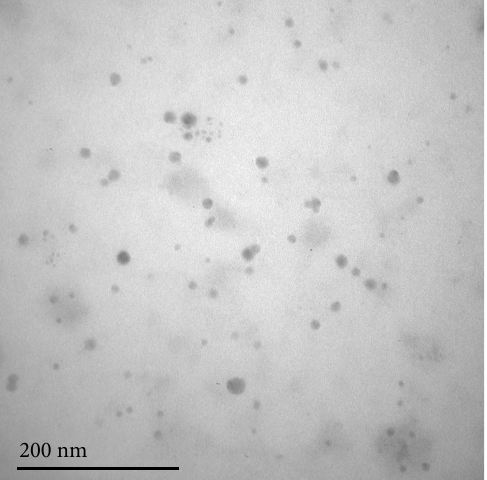
Figure 2 - Transmission electron microscopy image of silver nanoparticles solution. The nanoparticles present diameters of 10 to 15